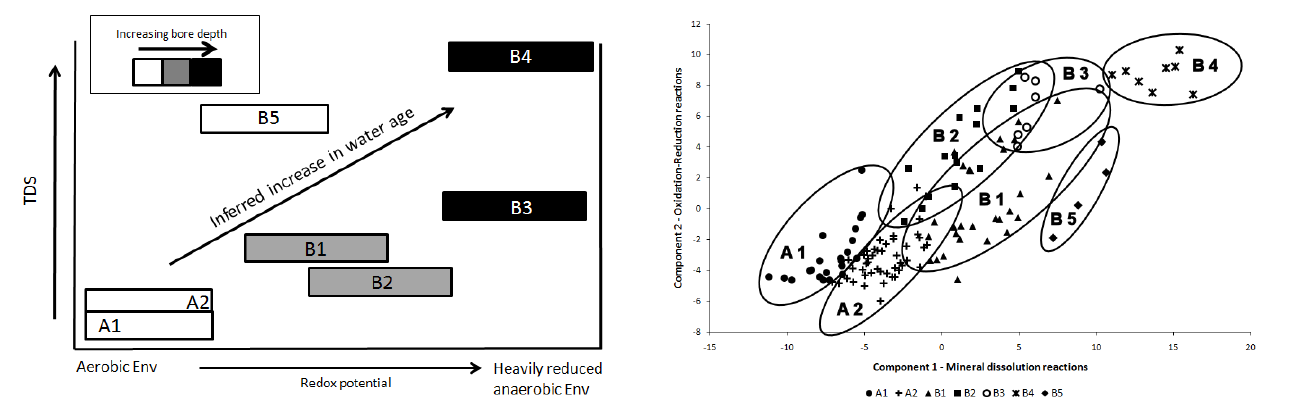
Fig. 7. Simplified schematic representation of differences amongst the seven clusters (A1–B5) in relation to their TDS, aquifer depth and redox condition. Scales of axes are simplified representations of increase only.